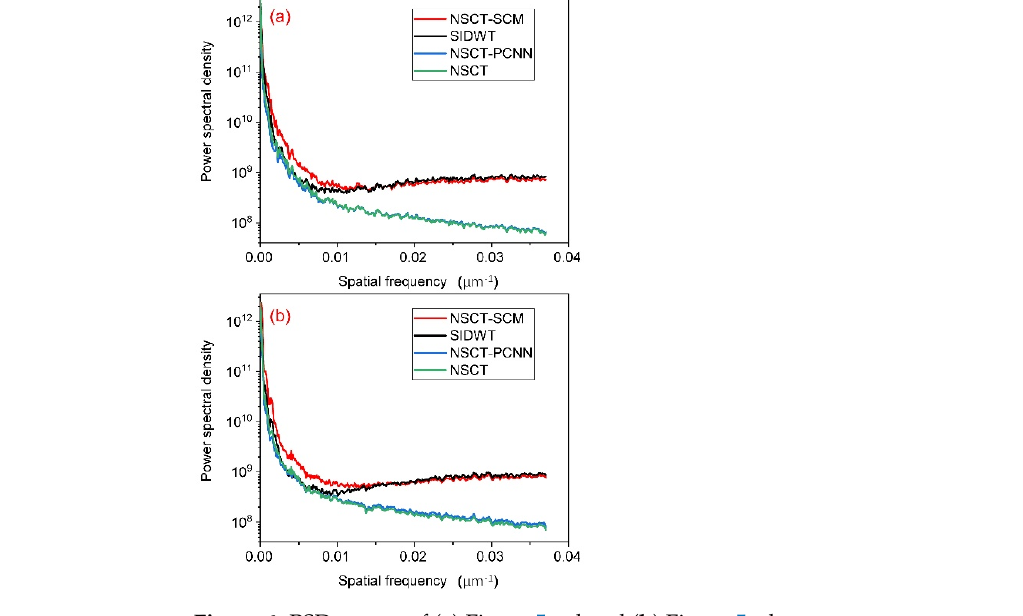
Figure 6. PSD curves of ( a ) Figure 5a–d and ( b ) Figure